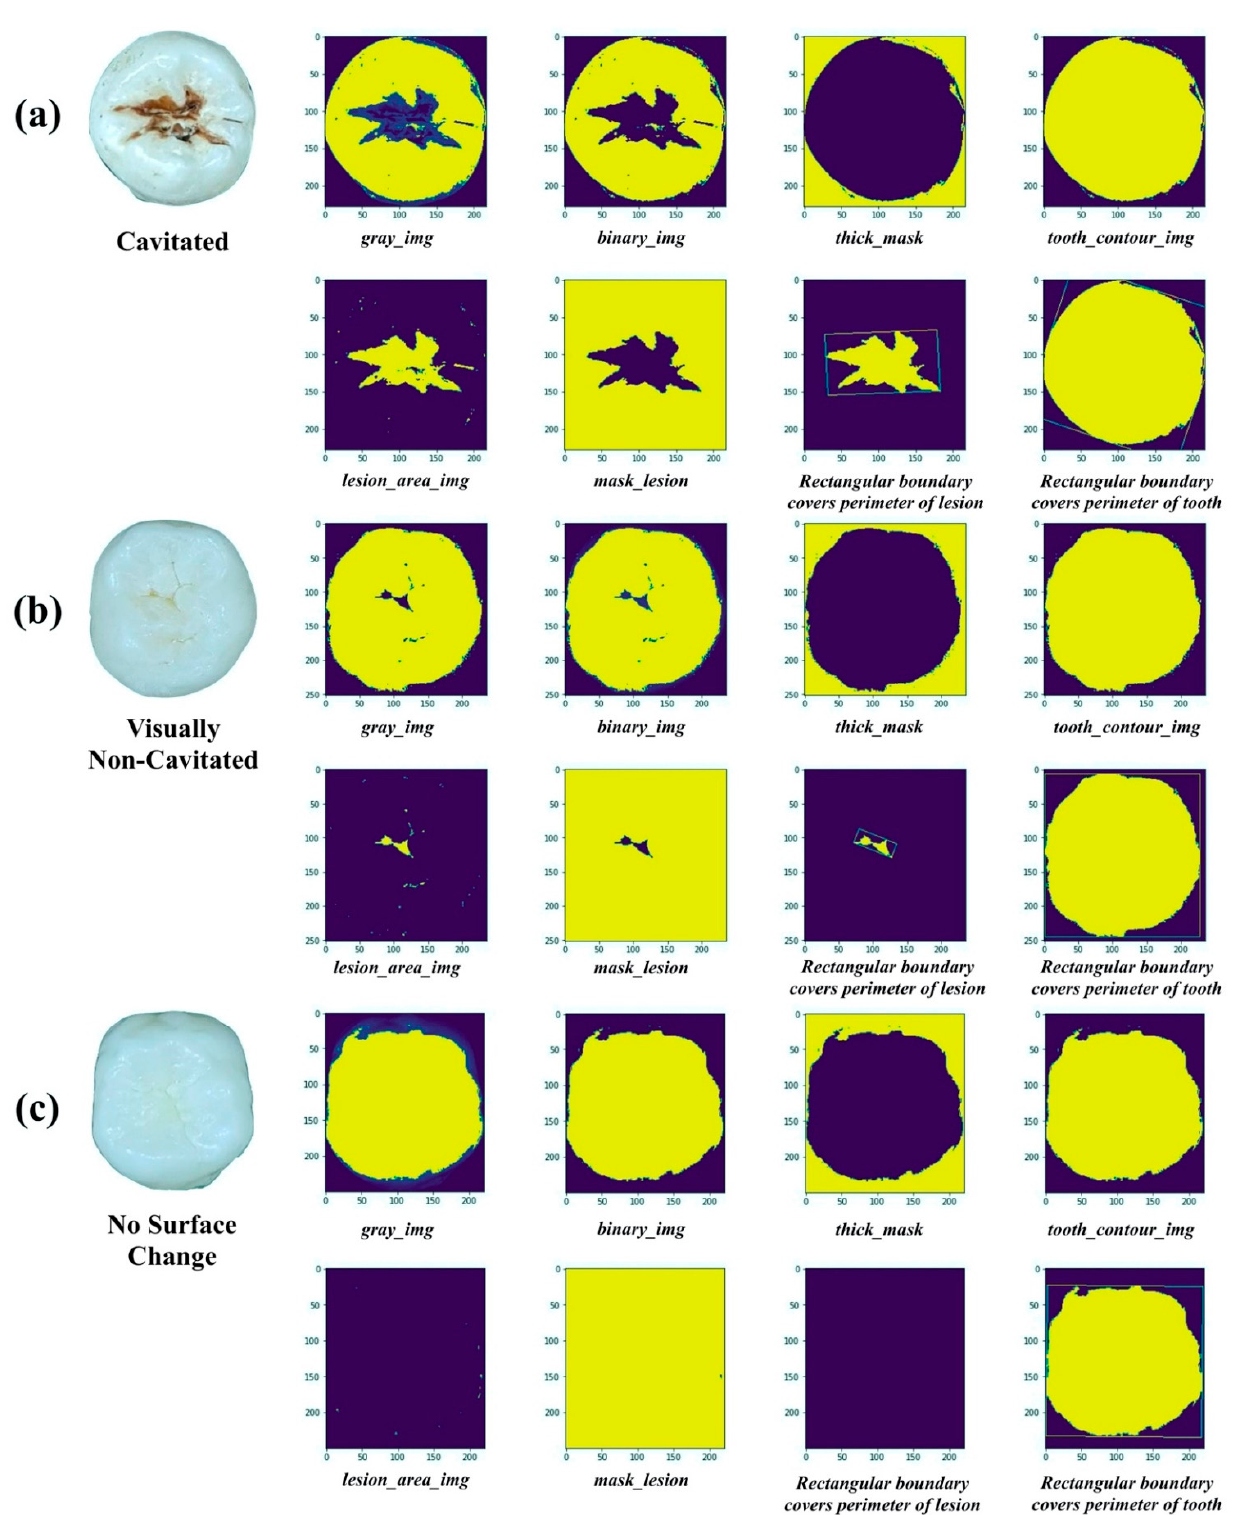
Figure 3. Proposed image processing method for caries detection. ( a ) Cavitated class; ( b ) Visually Non-Cavitated class; ( c ) No Surface Change class.